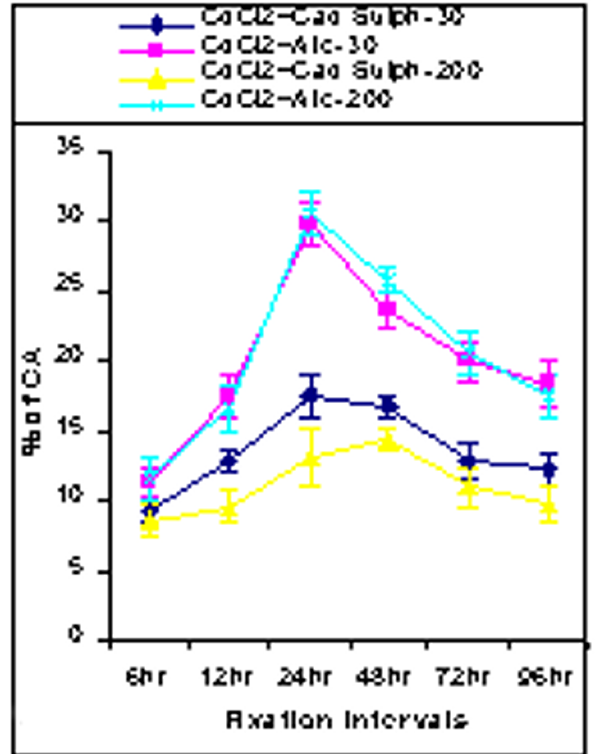
Figure 7 Showing time-dependent frequencies of Cad Sulph-30 post- fed and Cad Sulph-200 post-fed series versus their respective CdCl 2 treated alcohol-30 and alcohol-200 control mice. Chromosome aberration (CA)-5; Mitotic index (MI)-6; Micronucleated erythrocytes (MNE)-7 and Sperm head anomaly